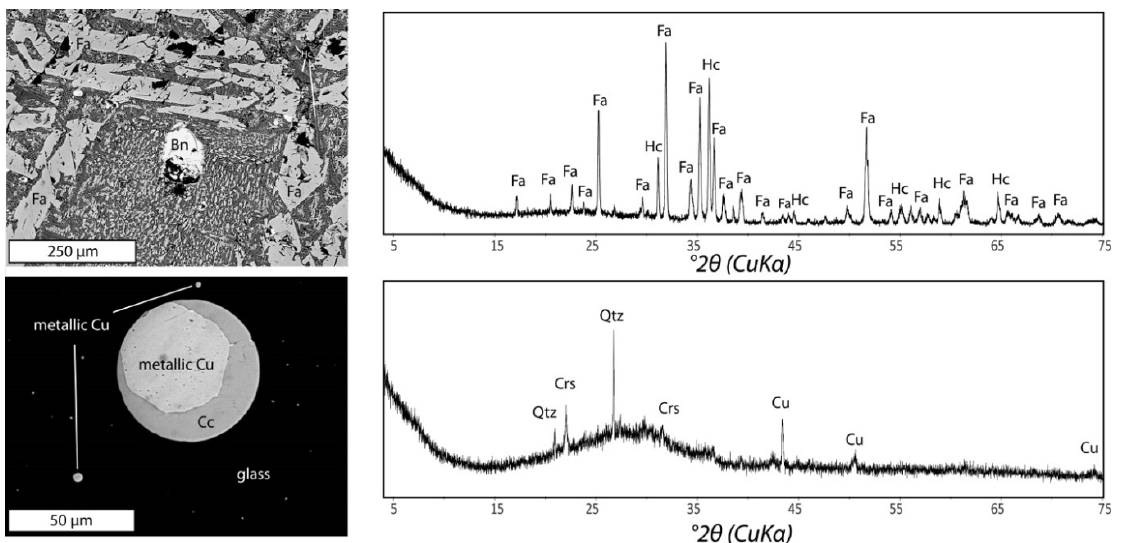
Figure 1. Scanning electron microscope images and XRD patterns of fresh samples of crystalline ( upper pictures ) and amorphous slag ( bottom pictures ). Abbreviations: Fa: fayalite, Hc: hercynite, Qtz: quartz, Crs: cristobalite, Cu: metallic copper, Bn: bornite, Cc: chalcocite.